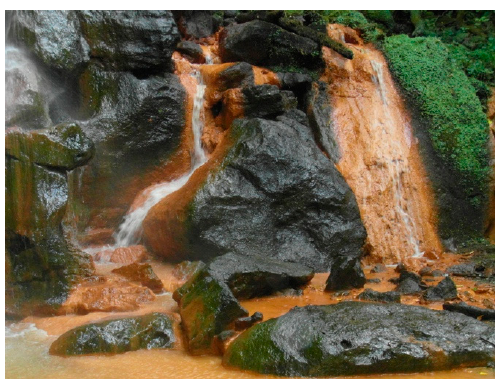
Figure 1. Red epilithic biofilm sampled at Infernaccio waterfalls.